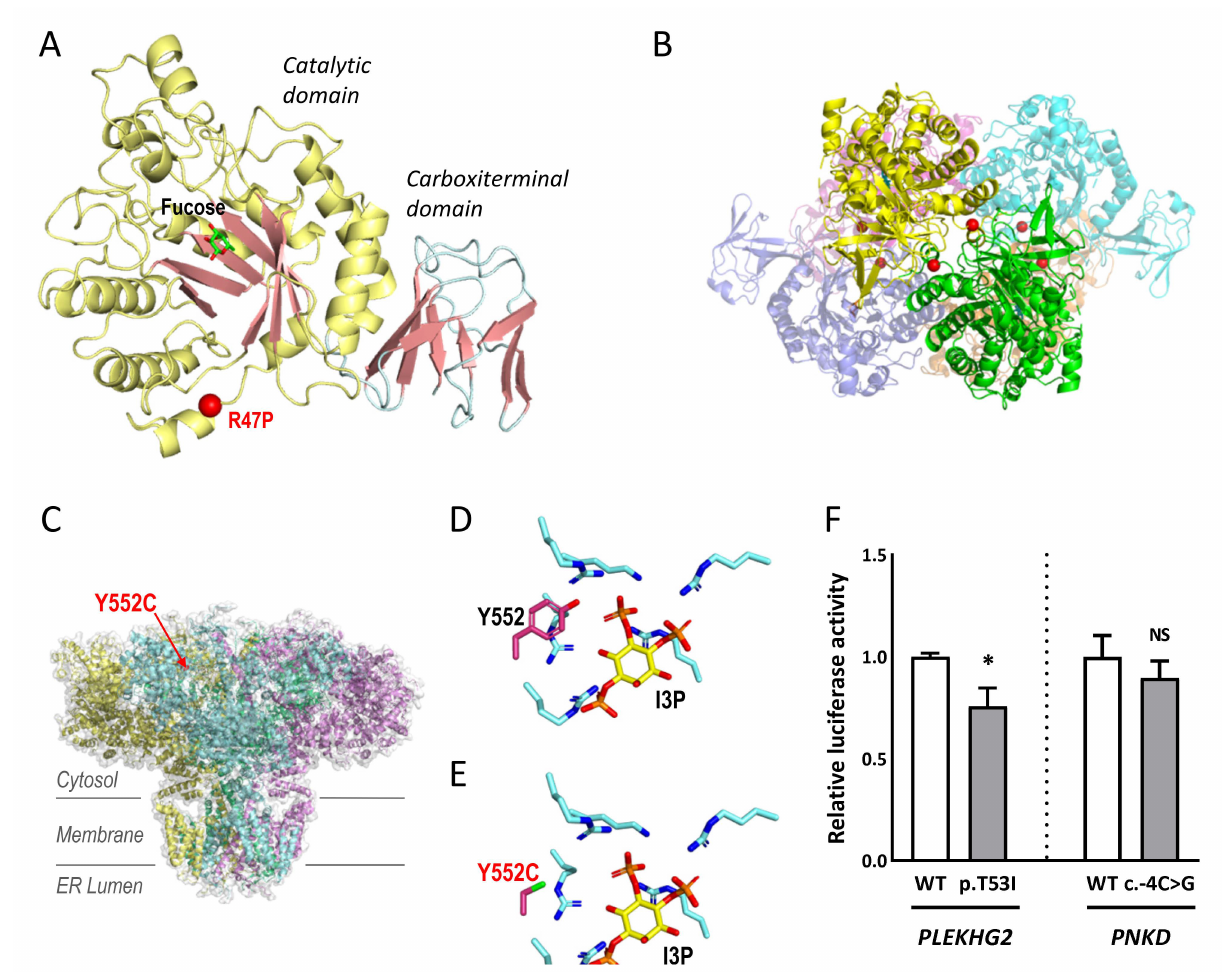
Figure 3. Structural modelling and luciferase assays. ( A , B ) FUCA1 p.R47P. ( A ) Structural modelling on HuFUCA1 subunit. The catalytic and carboxy terminal domains are coloured differently. Lo- calization of R47P is mapped with a red sphere. A molecule of fucose bound to the active site is shown in sticks representation. ( B ) Hexamer of TmFUCA1 (PDB 1ODU). Each subunit is shown with a different colour. The equivalent residue to R47 from HuFUCA1 is indicated by red spheres, to show its participation in the intersubunit surface. ( C – E ) ITPR1 p.Y552C: ( C ) The cryo-EM structure of ITPR1 tetramer (PDB 7LHE) is represented in an orientation along the membrane plane. Each subunit is shown with a different colour. Y552 is mapped in one of the subunits with a red sphere and labelled. ( D , E ) Detail of the IP3 binding site ( D ), PDB 1N4K, and modelling of the Y5552C variant ( E ). The side chain of tyrosine or cytosine at position 552 as well as those from the lysine/arginine cluster coordinating the phosphoryl groups of I3P are shown in stick representation. I3P is also shown in stick representation with carbon atoms coloured in yellow. Oxygen, nitrogen, phosphorus, and sulphur atoms are coloured red, blue, orange, and green respectively. ( F ) Luciferase assays to assess PLEKHG2 p.T53I and PNKD c.-4C>G variants in transfected HEK293T with expression constructs for wild-type (WT) and mutants. The luciferase activity was normalised to the WT. Data represent the mean ± SEM of three independent experiments performed in triplicate. * p < 0.05; n.s., not